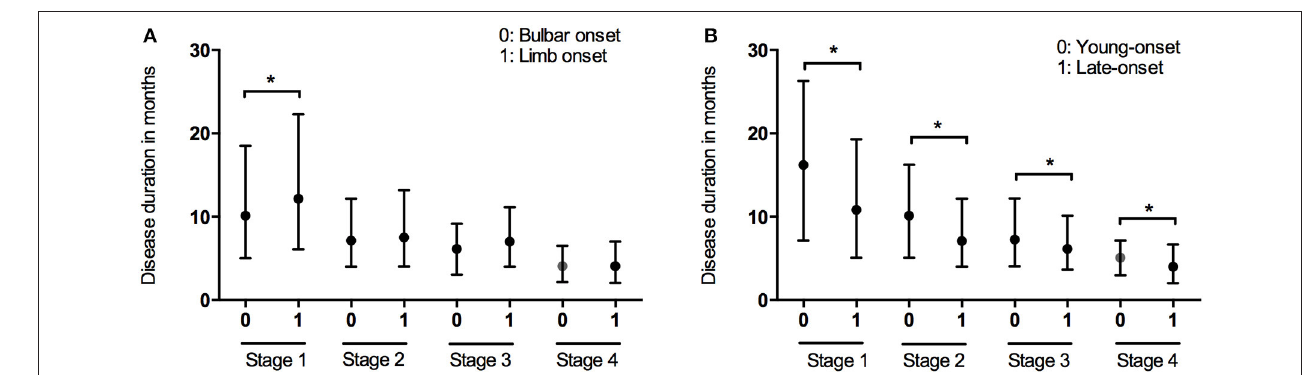
FIGURE 2 | Box plot of duration in months spent at each stage in patients with different onset form (A) and onset of age (B) . * P < 0.05.